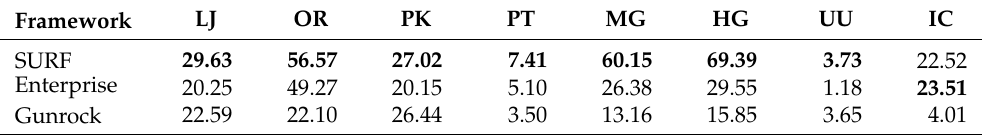
Table 5. BFS performance measured in GTEPS (billions of traversed edges per second), i.e., the higher the GTEPS, the better the performance. The best performance is indicated in bold.